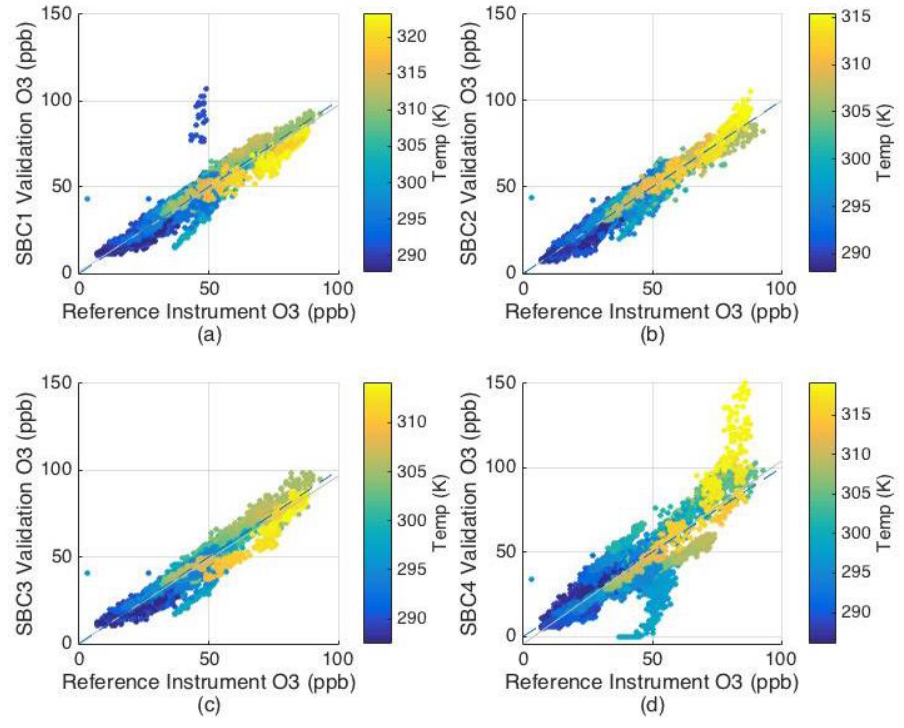
Figure 2. Scatterplots of sensor data versus reference data for UPod SBC1 ( a ); SBC2 ( b ); SBC3 ( c ); and SBC4 ( d ) during the validation